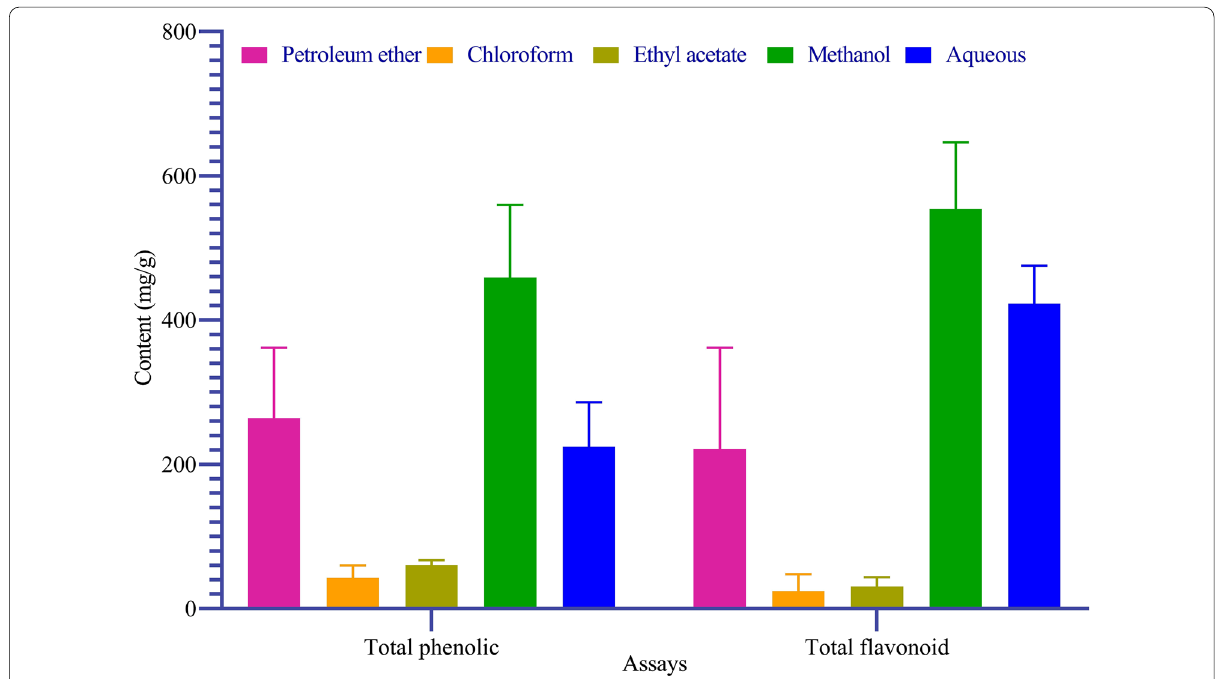
Fig. 2 Total phenolics and flavonoids content in E. ramosissimum stem extracts